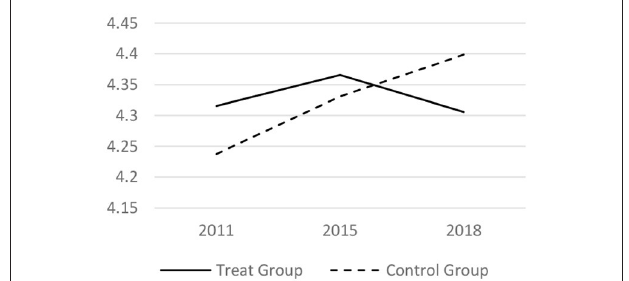
FIGURE 1 | Parallel trend of outpatient expenses (Yuan).